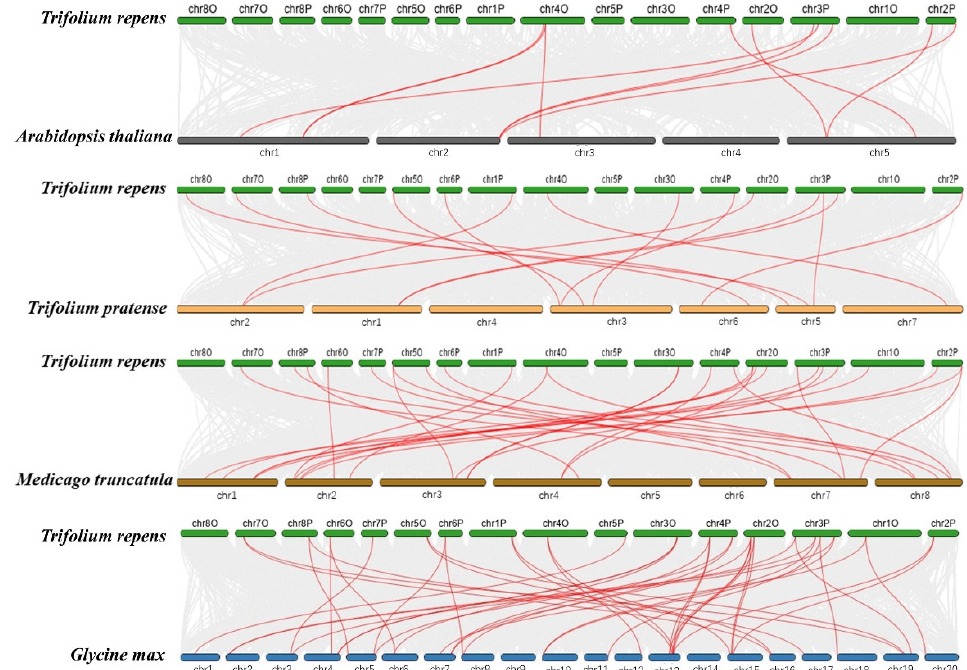
Figure 7. Collinearity analysis of SPL gene families between T. repens and representative species. The red line showed the collinearity of SPL gene family in T. repens and corresponding representative species. Other collinearity between genomes is indicated by gray lines.